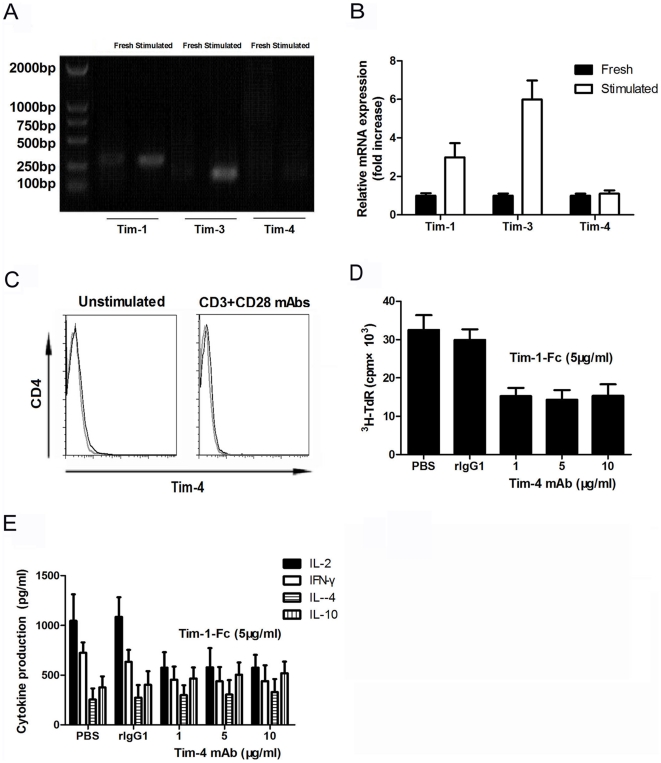
Tim-4 is not expressed by mouse T cells.Freshly isolated or anti-CD3 (2 µg/ml), anti-CD28 (1 µg/ml) mAbs activated CD4+ T cells were tested by RT-PCR (A, B) and stained with anti-mouse Tim-4-PE (black line) or specific isotype control (gray line) and subjected to FCM analysis. Data were representative of three experiments (C). CD4+ T cells were cultured with anti-CD3 and anti-CD28 mAbs in the presence of PBS or control rat IgG1 or Tim-1-Fc (5 µg/ml) together with anti-Tim-4 mAb (1, 5, 10 µg/ml) for 72 h. T cells proliferation and cytokines secretion were detected by 3H thymidine uptake (D) or ELISA (E).